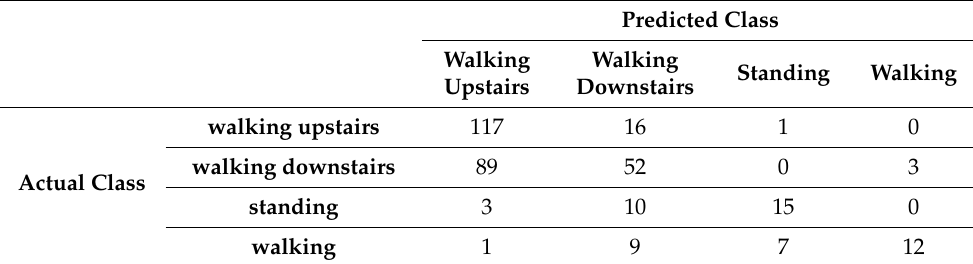
Table 8. Confusion matrix for normalized gyroscope data with